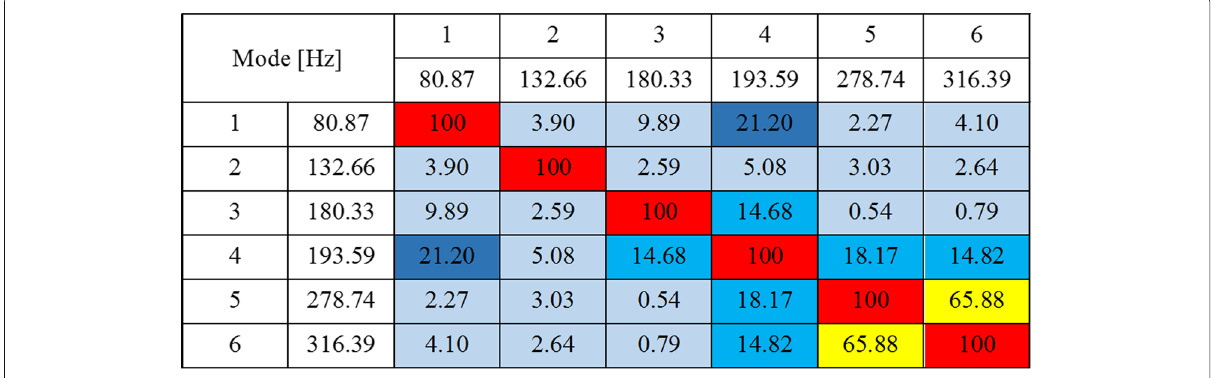
ω n being the natural frequency. It is normalised with respect to the EMA results, as these results are based on the data collected from the actual system response. The mode shapes obtained numerically and experimentally are presented in Fig. 18.